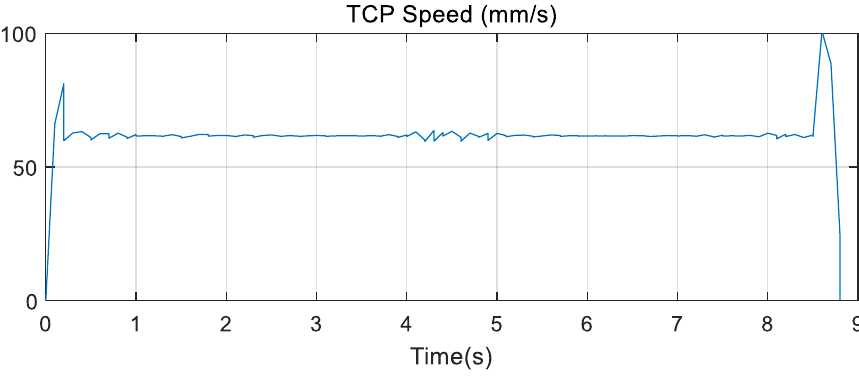
Figure 19. TCP speed in trajectory planned using 43 points.